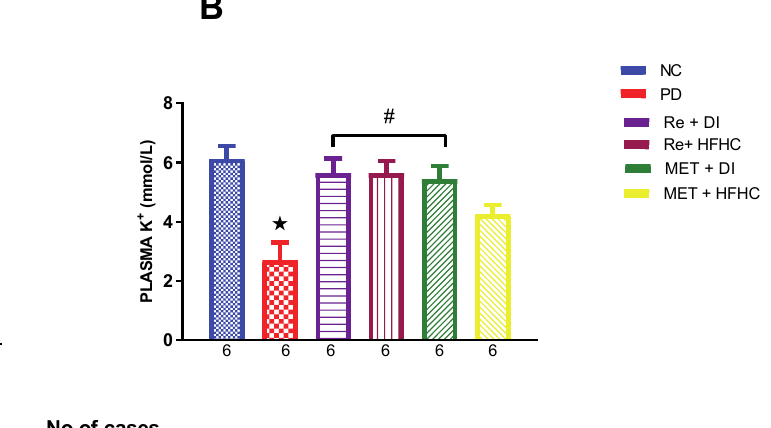
(PD), metformin and diet intervention (MET + DI), metformin and high-fat/high-carbohydrate diet